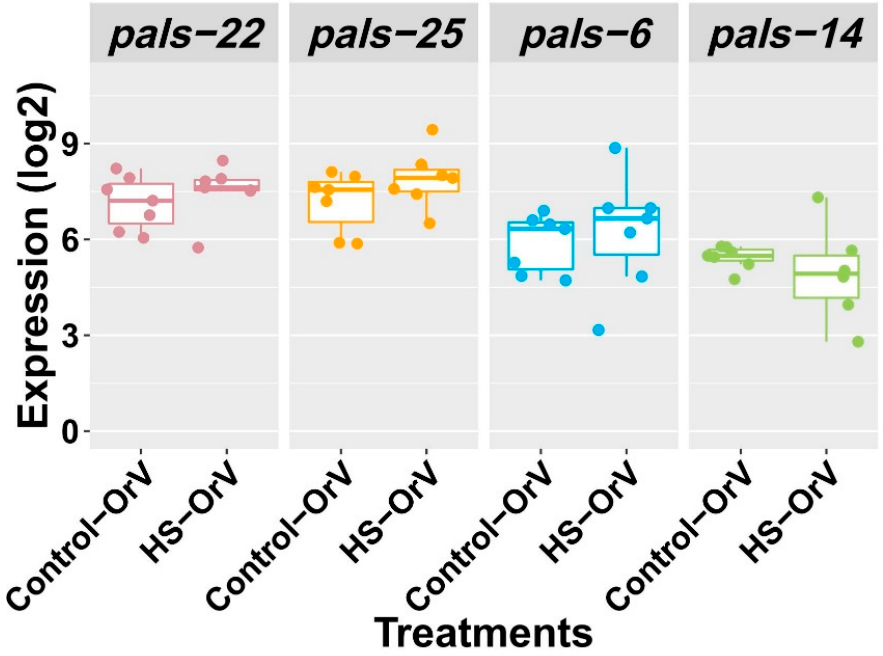
Figure 6. Gene expression of pals-22, pals-25, pals-6, and pals-14 in JU1580 after HS and OrV infection. No significant differences were found between the side-by-side comparisons. Tukey HSD test, p > 0.05. Control-OrV: only OrV infection; HS-OrV: HS applied before the OrV infection. Dots: infected biological replicates.